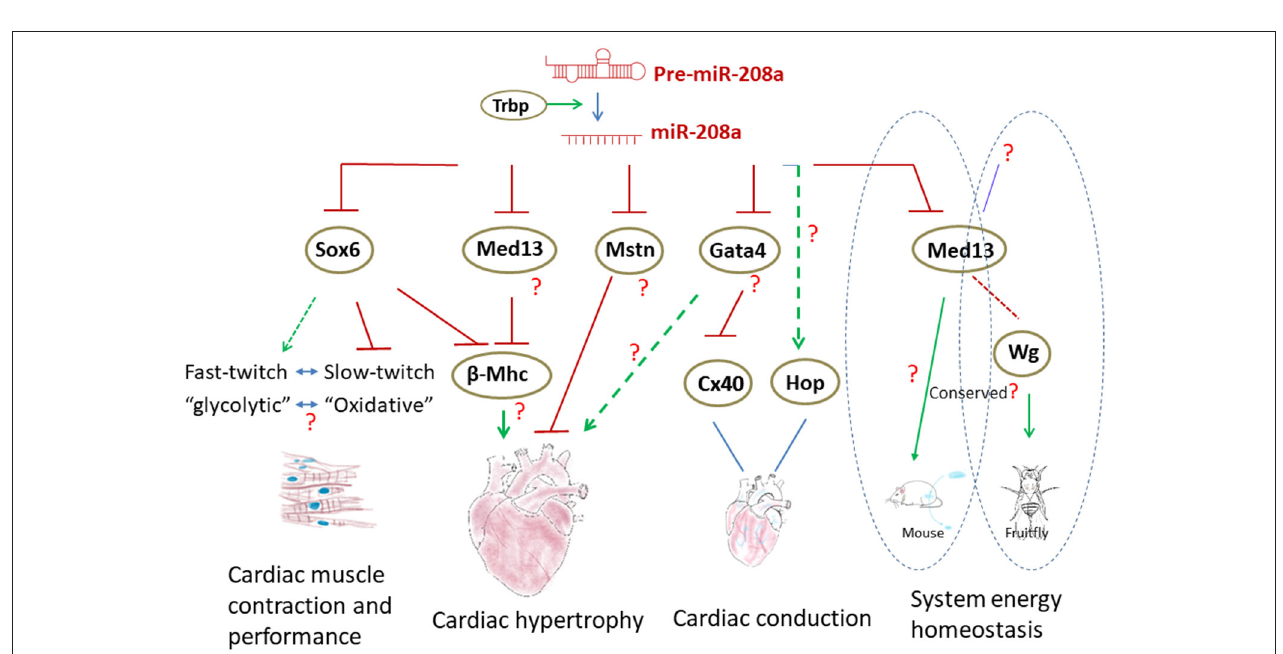
FIGURE 2 | The functional roles of miR-208a. miR-208a participates in regulating multiple pathophysiological processes, such as cardiac hypertrophy, disordered cardiac conduction and contraction and system energy dyshomeostasis.